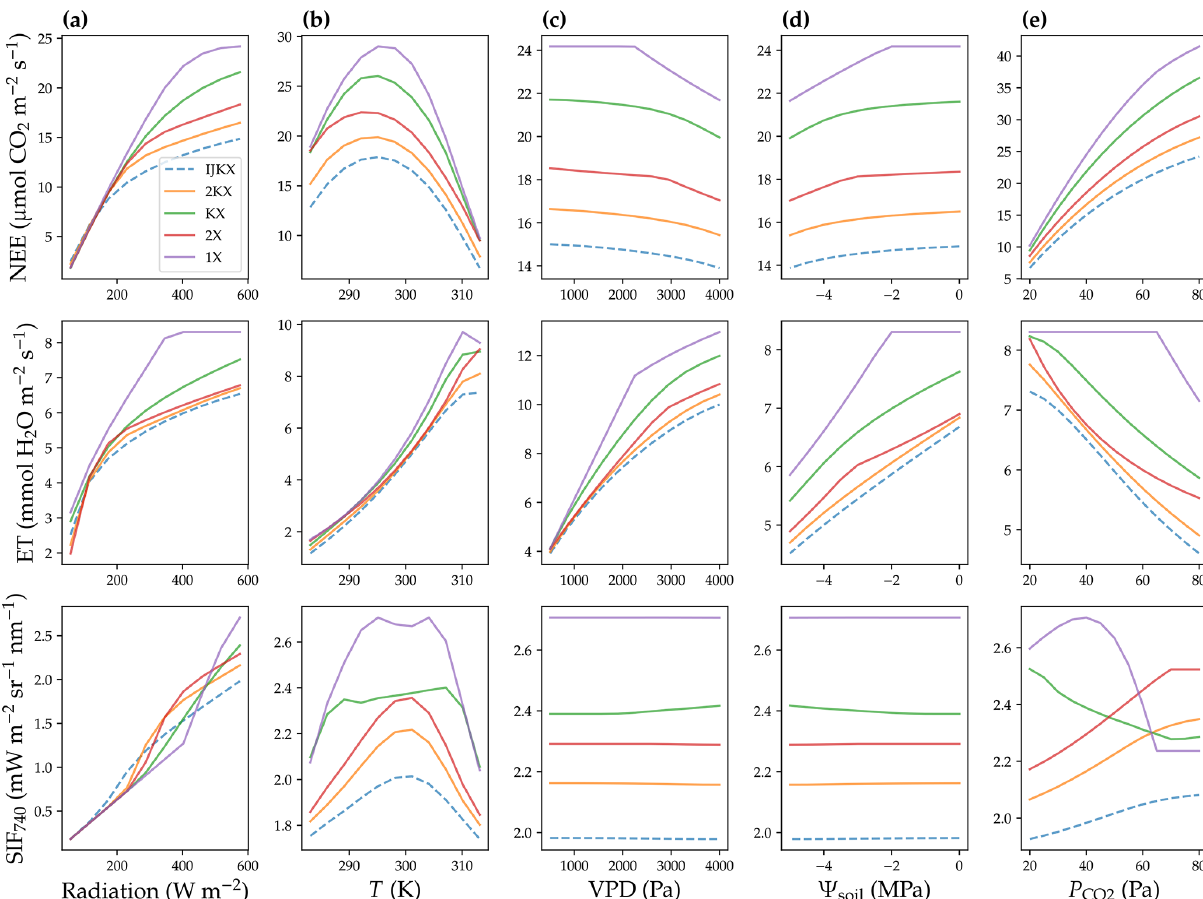
Figure 5. Net ecosystem exchange of CO 2 (NEE, normalized per ground area), evapotranspiration rate (ET, normalized per ground area), and solar-induced fluorescence (SIF) responses to changes in environmental cues. (a) Responses to total radiation. (b) Responses to air and leaf temperature ( T ). (c) Responses to atmospheric-vapor-pressure deficit (VPD). (d) Responses to soil water potential ( (cid:57) soil ). (e) Responses to atmospheric CO 2 partial pressure ( P CO ). This sensitivity analysis was done assuming exponentially decreasing photosynthetic capacity 2 in the lower